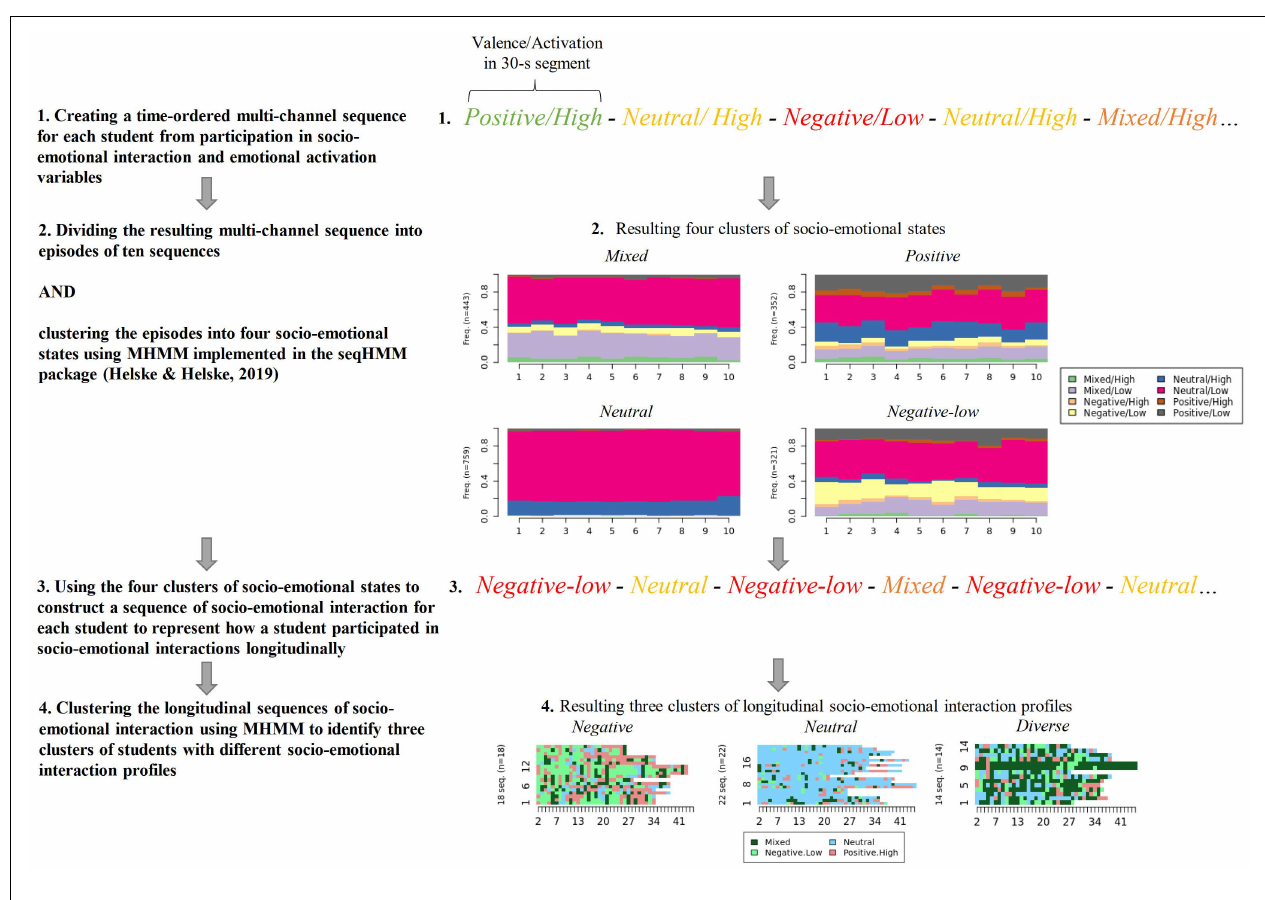
FIGURE 2 | The two levels of the clustering approach (López-Pernas and Saqr, 2021) for identifying socio-emotional interaction